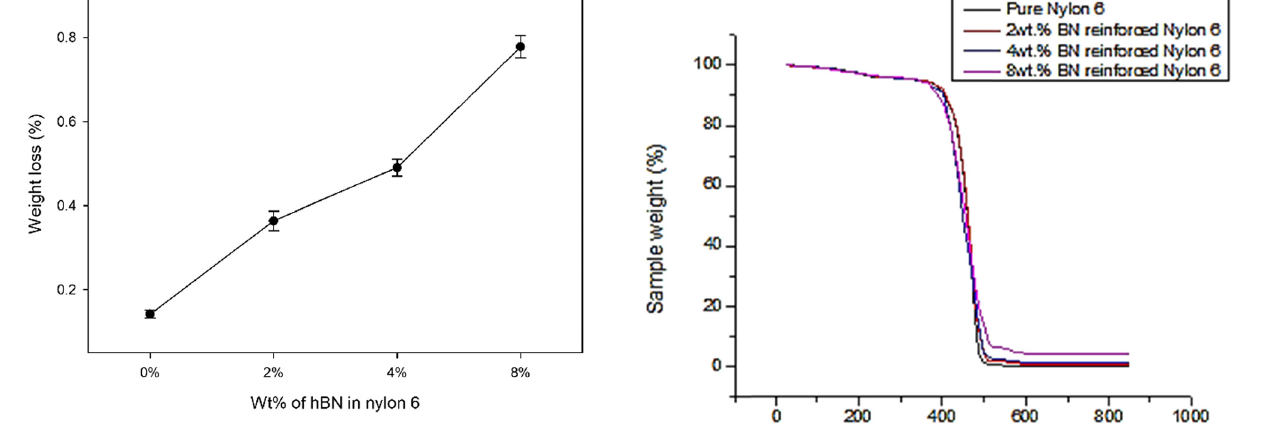
Figure 10: Weight loss in abrasion with H - 18 abrasive wheel. 3.4